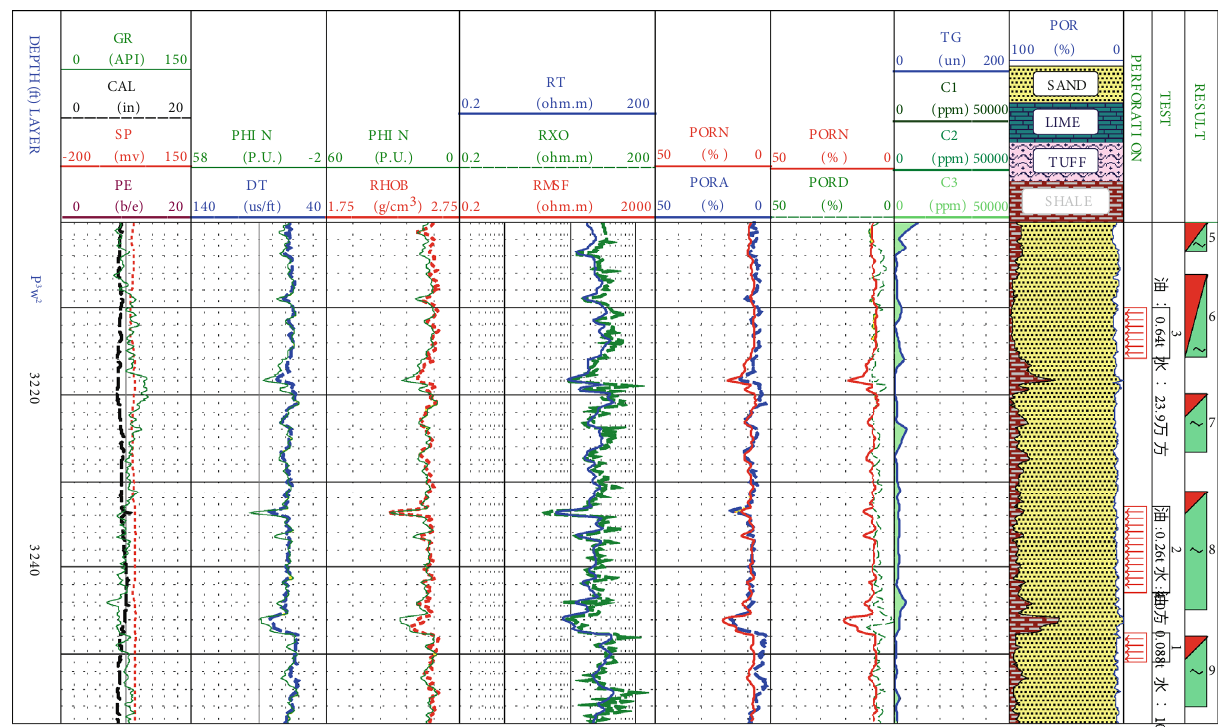
Figure 7: Log interpretation results of Ke011 well.